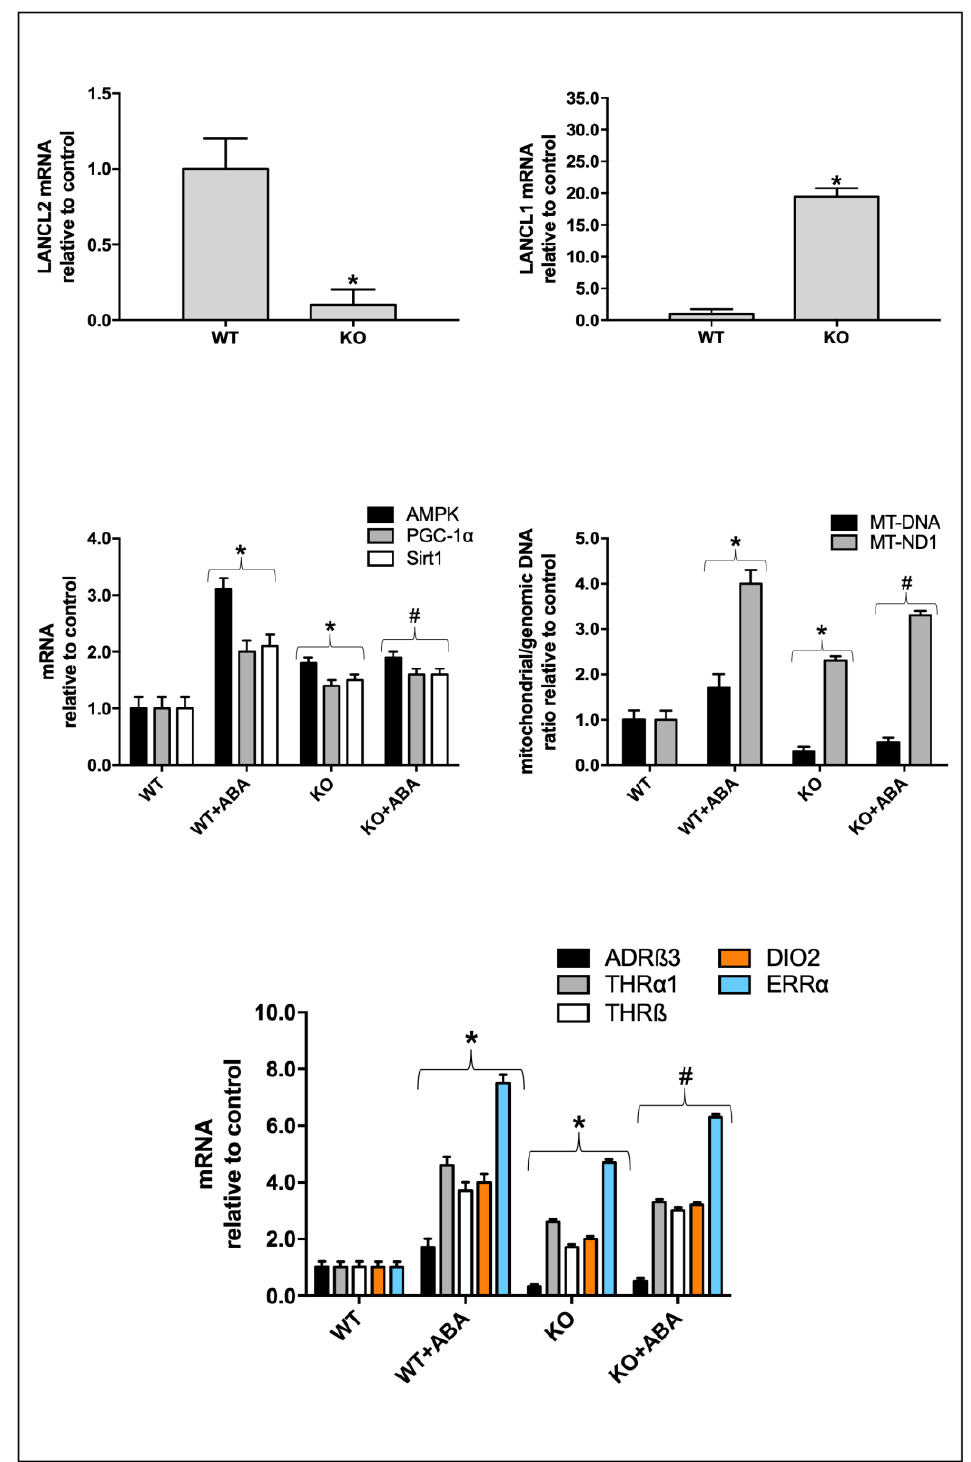
Figure 10. Chronic ABA treatment increases transcription of “browning” receptors, enzymes and transcription factors and mitochondrial DNA content in the BAT of LANCL2 − / − mice. Male, LANCL2 − / − mice (KO) and their wild-type siblings (WT), 5 per group, were treated without or with ABA (1 μ g/kg BW/day, administered in the drinking water) for 4 weeks. At the end of treatment, mice were euthanized, and samples of brown adipose tissue were taken for qPCR analysis. Results shown are mRNA levels relative to the WT expression level and are the mean ± SD from 5 mice per group. p values are calculated by unpaired t -test. Upper left panel, LANCL2 mRNA; upper right panel, LANCL1 mRNA; central left panel, AMPK, PGC-1 α and Sirt1 mRNAs; central right panel, mitochondrial/genomic DNA ratio (MT-DNA and MT-ND1); lower panel, β -adrenergic receptor 3